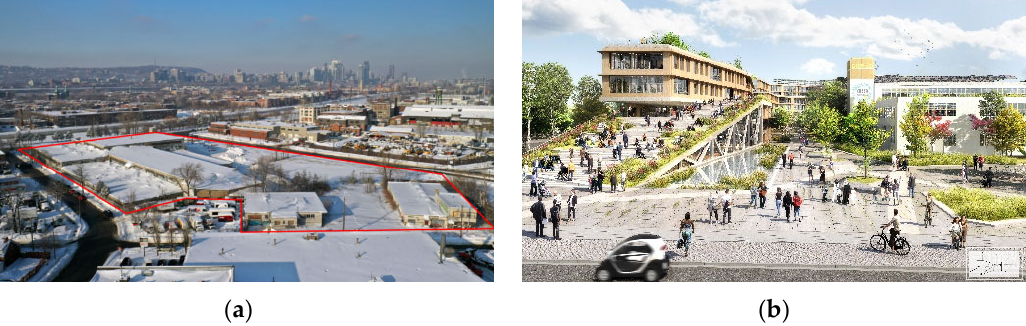
Figure 2. The geometry of the C40 site as a case study, selected site view ( a ), designed and renovated blocks ( b ). blocks ( b